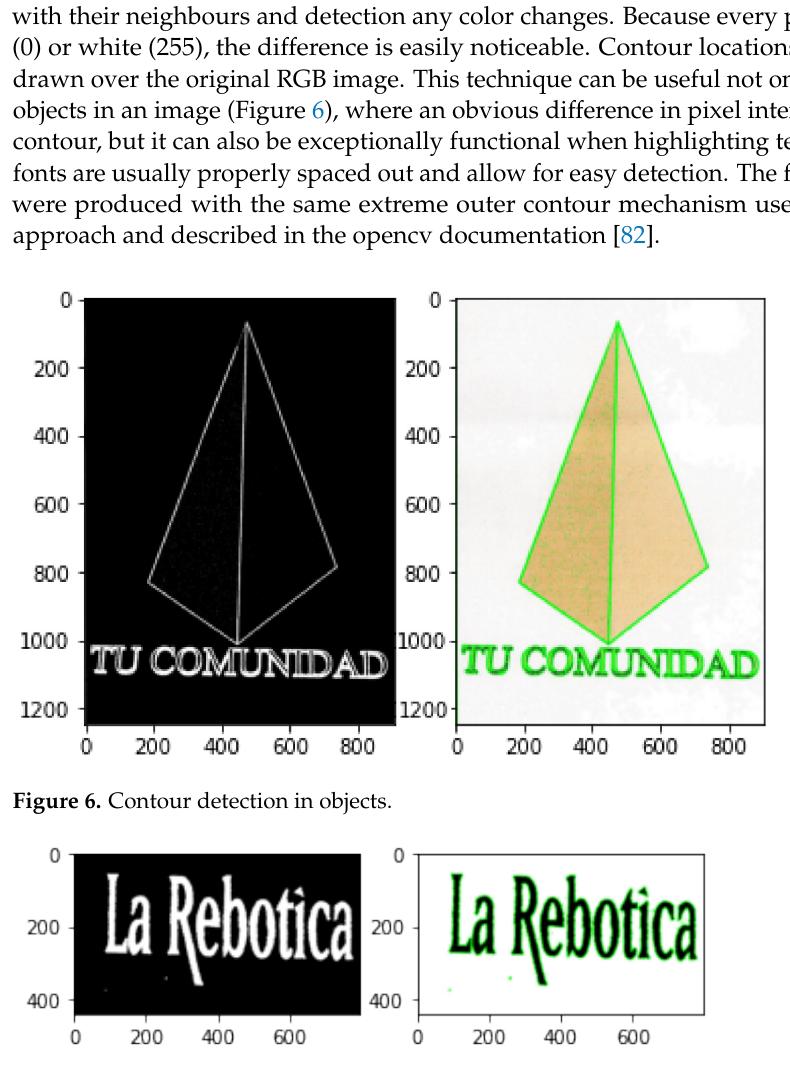
Figure 7. Contour detection in